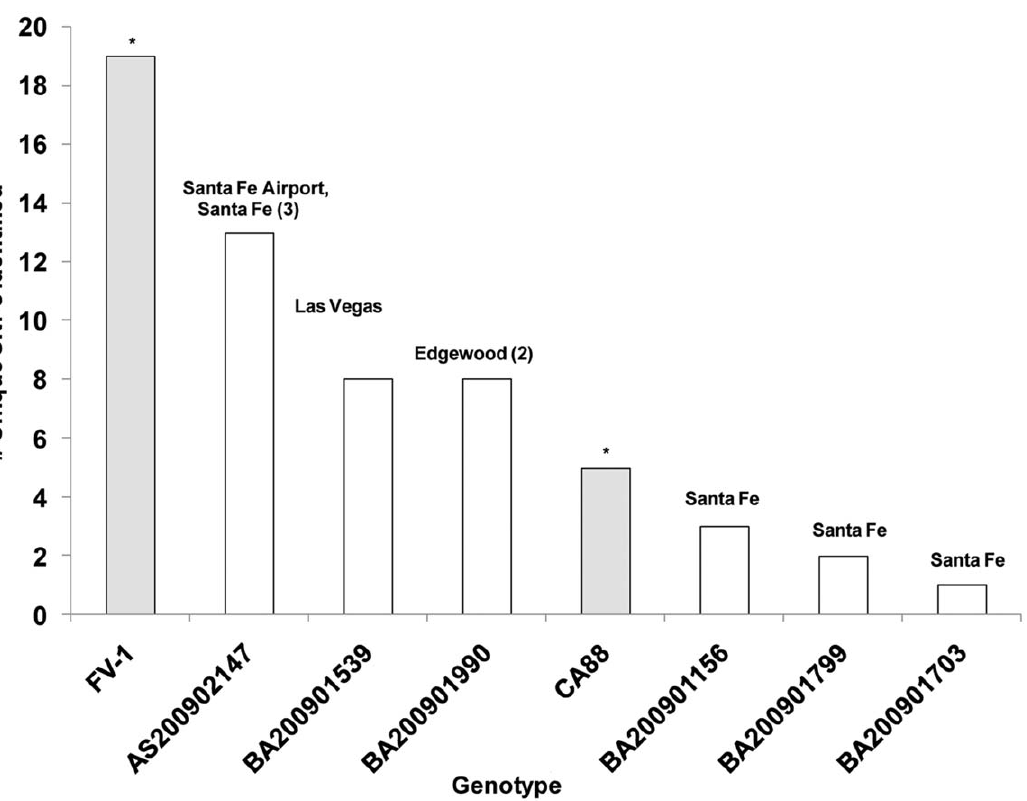
Figure 4. SNP Discovery in New North American Y.pestis Genome Sequences. The number of strain-specific newly identified SNPs relative to CO92 is plotted for each isolate. Previously sequenced strains are indicated by shaded bars with the location of origin and the number of strains showing identical genotypes in parentheses. * Number of newly identified SNPs described in references [10,11].